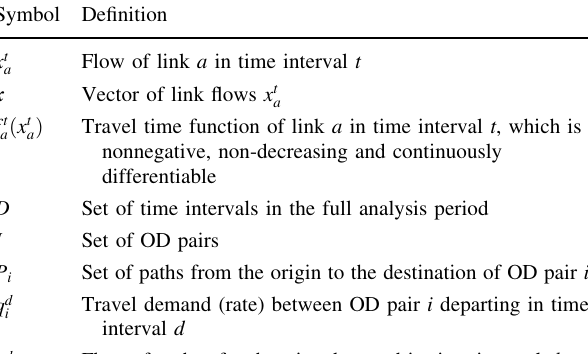
Table 1 Variables and parameters used in problem